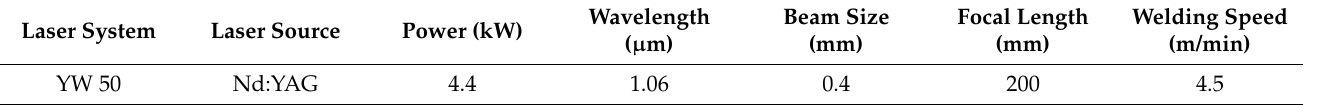
Table 4. Laser parameters used for